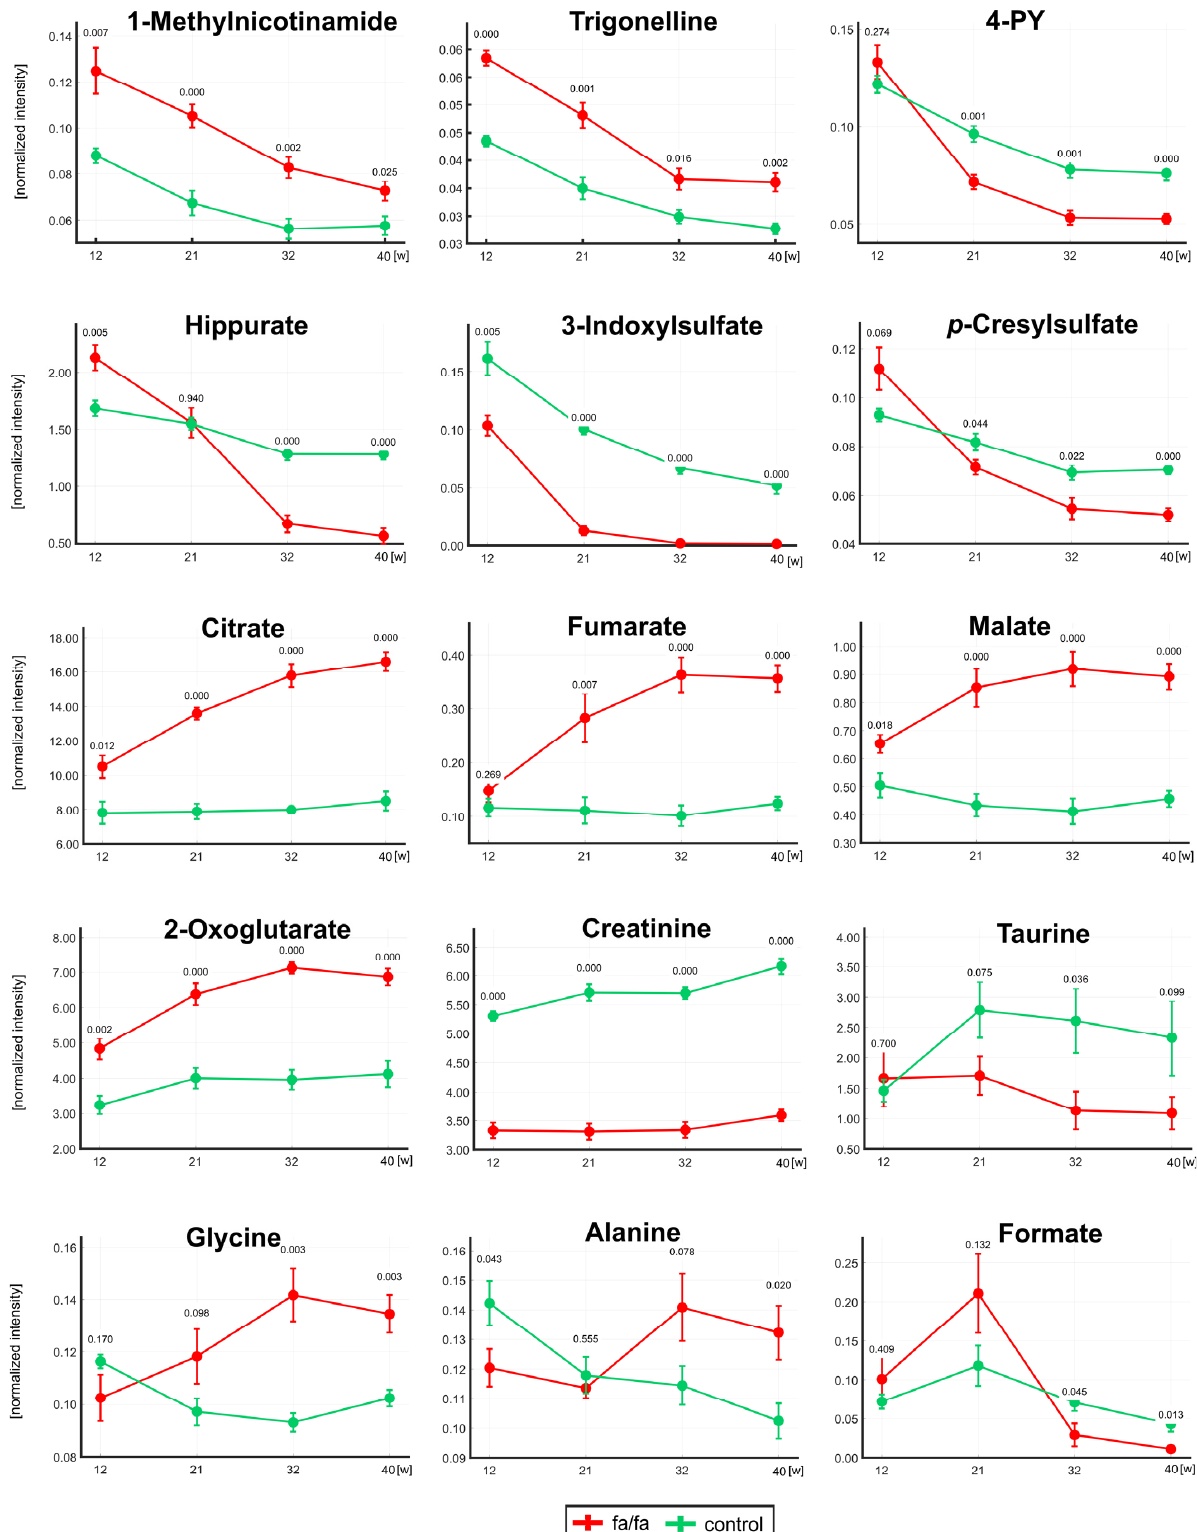
Figure 4. The development of normalized intensities for selected metabolites at 12, 21, 32, and 40 weeks. The statistical significance was analyzed by Student’s t -test ( fa / fa vs. controls). p -values and standard deviation error bars are given for each collection time. Fa / fa rats are marked in red, controls in green.